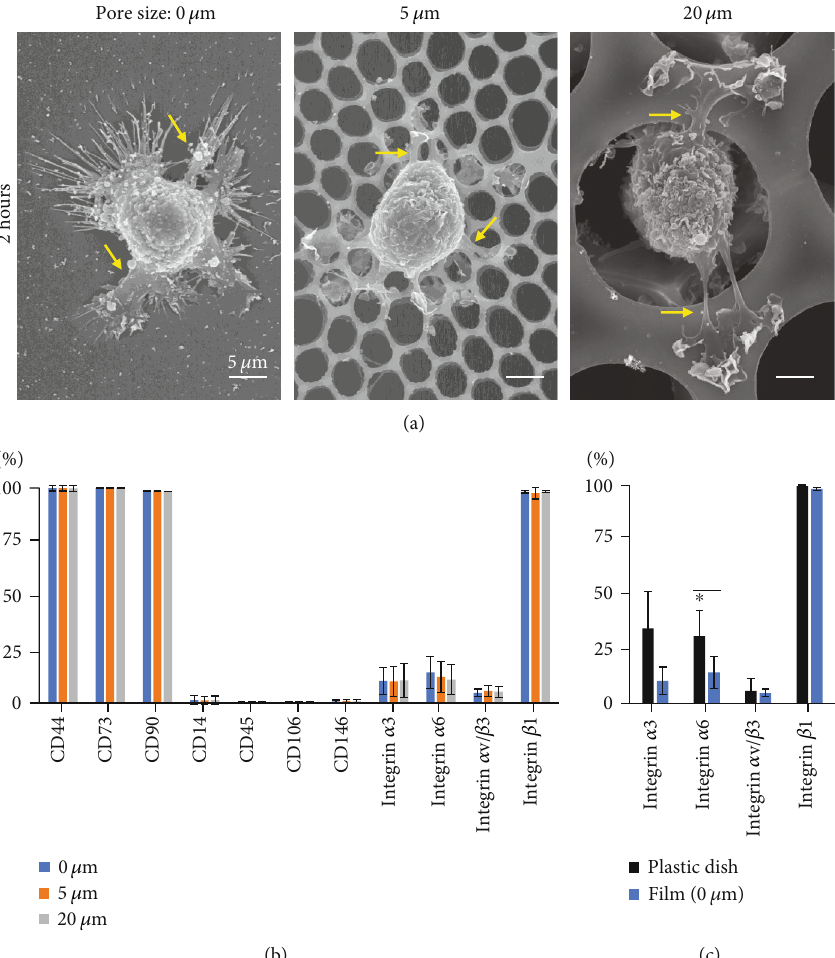
Figure 2: SEM images and surface markers of synovial MSCs plated onto honeycomb fi lms. (a) SEM images of honeycomb PLA fi lms after plating synovial MSCs. Synovial MSCs ( 1 : 0 × 10 4 in 500 μ L medium) were plated on PLA fi lms without pores (0 μ m) or with 5 μ m and 20 μ m pores and observed from above after 2h. Representative pseudopodia are indicated with yellow arrows. (b) Surface markers of synovial MSCs one day after seeding onto the fi lm. Means and standard deviations are shown ( n = 3 ). (c) Surface markers of synovial MSCs before and one day after seeding onto 0 μ m fi lm. ∗ P < 0 : 05 . P values were determined by paired Student ’ s t